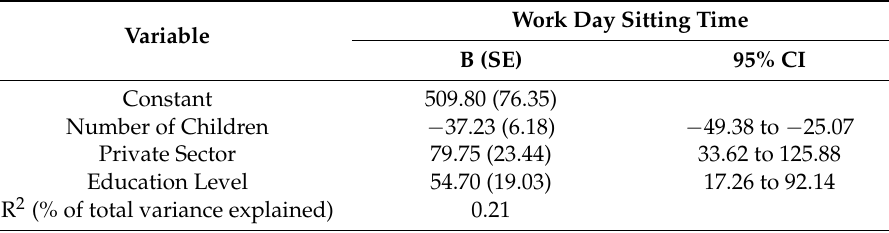
Table 5. Factors influencing work day and non-work day sitting